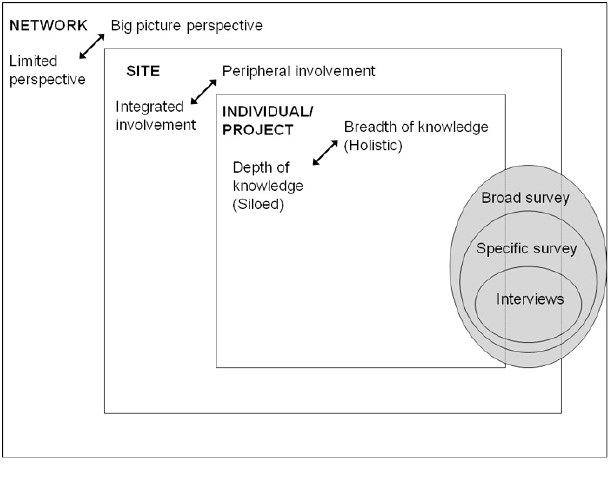
Fig. 1 . In this study we employed three iterative rounds of data collection from surveys to interviews. Analysis of the coded interviews alongside the survey data revealed general trends in responses across different scales in the Long Term Ecological Research (LTER)